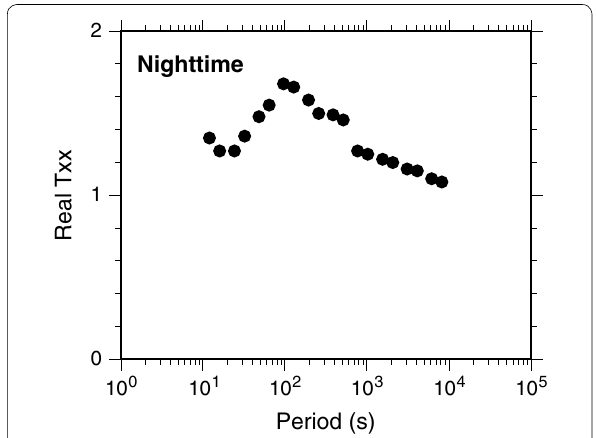
Fig. 7 Period dependence of the interstation transfer function between CB and the base station PRM. Results are shown for the real part of the nighttime H-component (Txx) transfer function